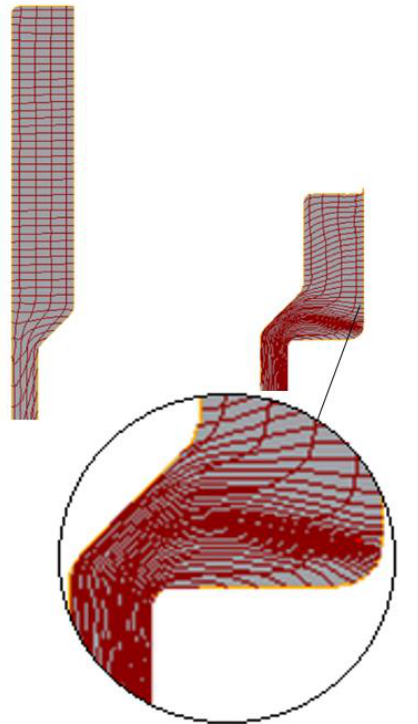
Table 1. Thickness distribution of the forming steps.